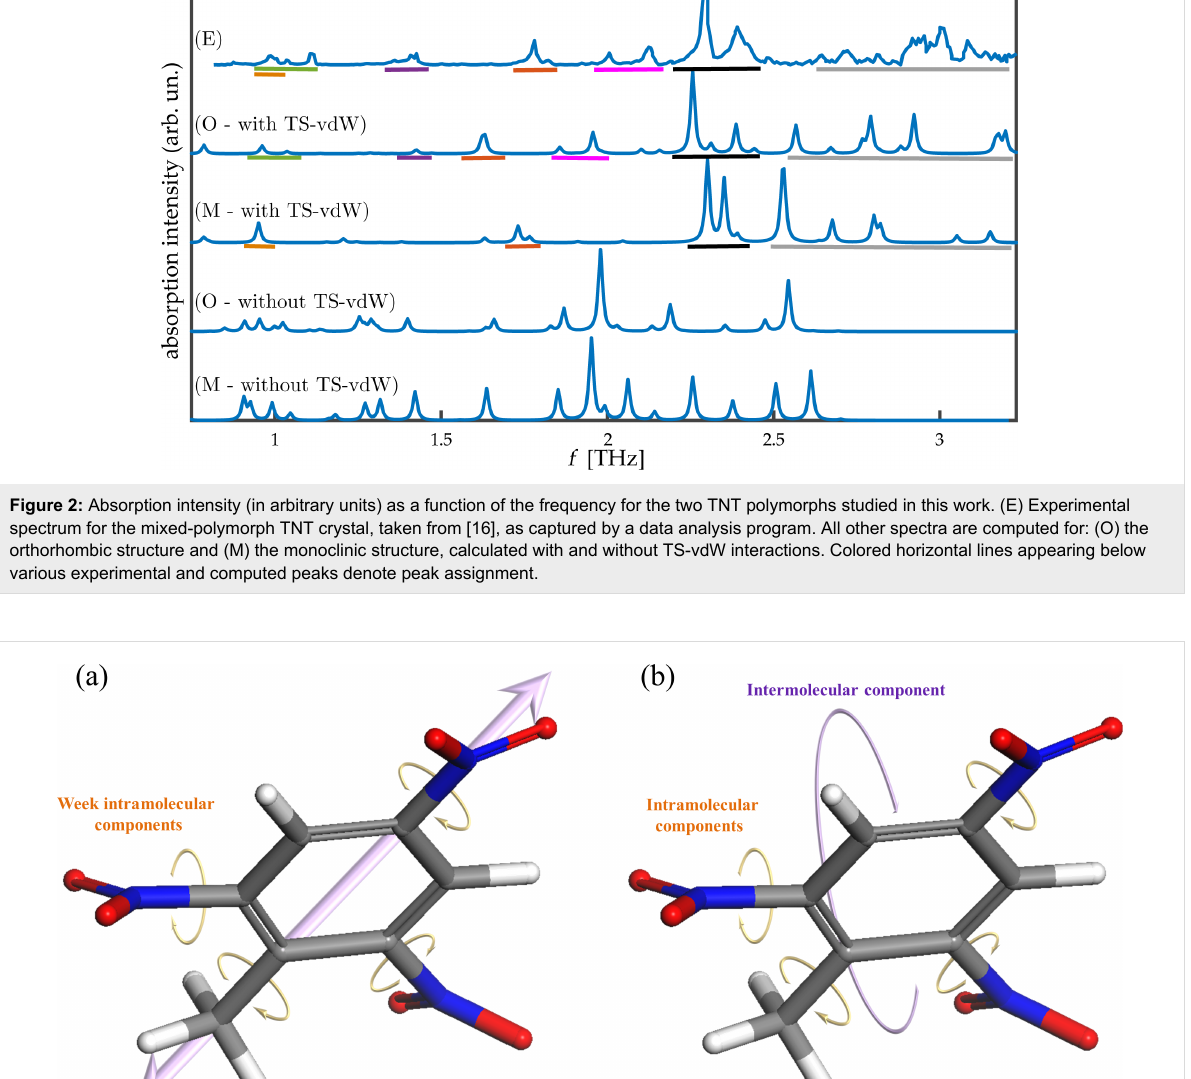
torsion of nitro and methyl groups, marked by orange arrows in the figure. This is in agreement with the assignment assumed in [16], as well as with force-field calculations reported in